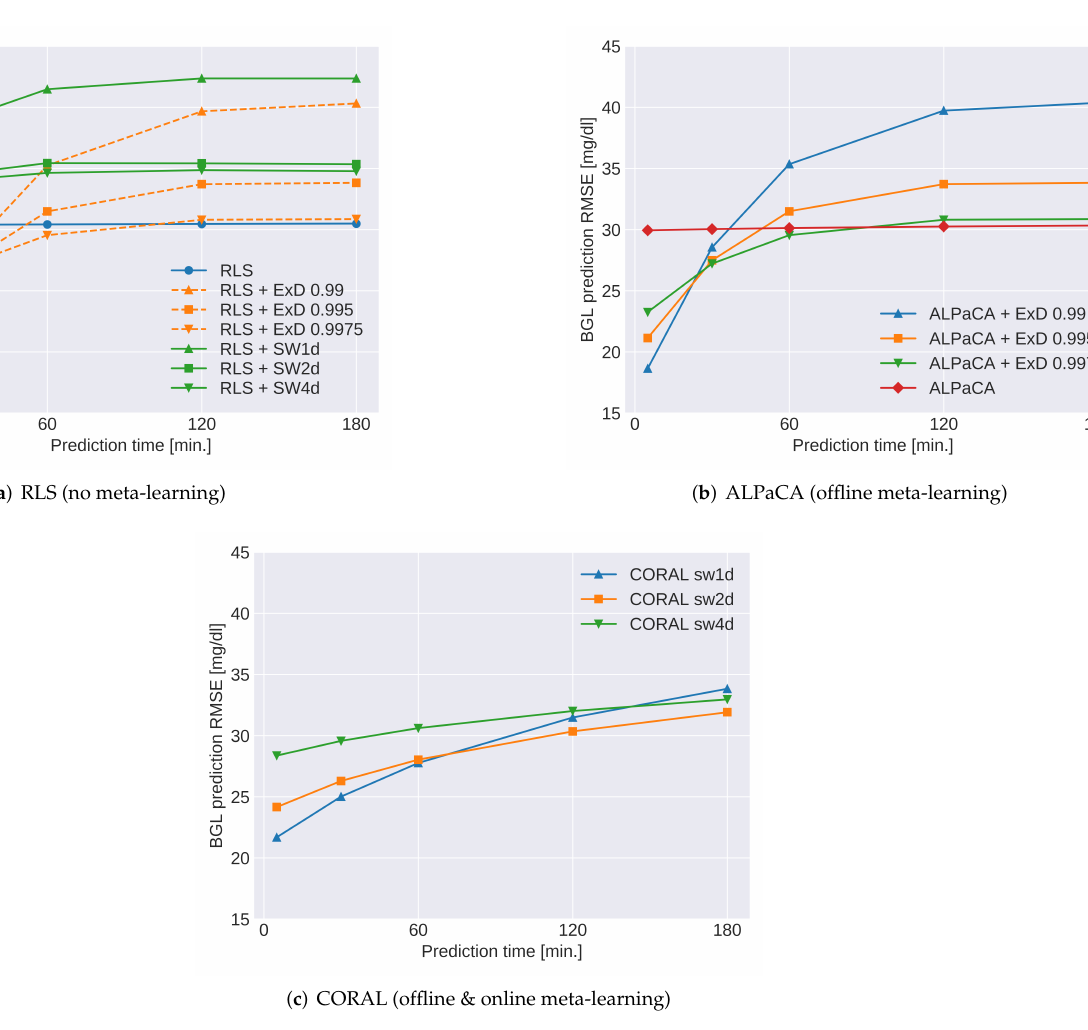
Figure 9. Blood glucose level (BGL) prediction RMSE for the non-stationary target model (adult#001 ↔ adult#003) with three base models—RLS, ALPaCA and CORAL. The x-axis shows its prediction time in minutes, which shows how far into the future it